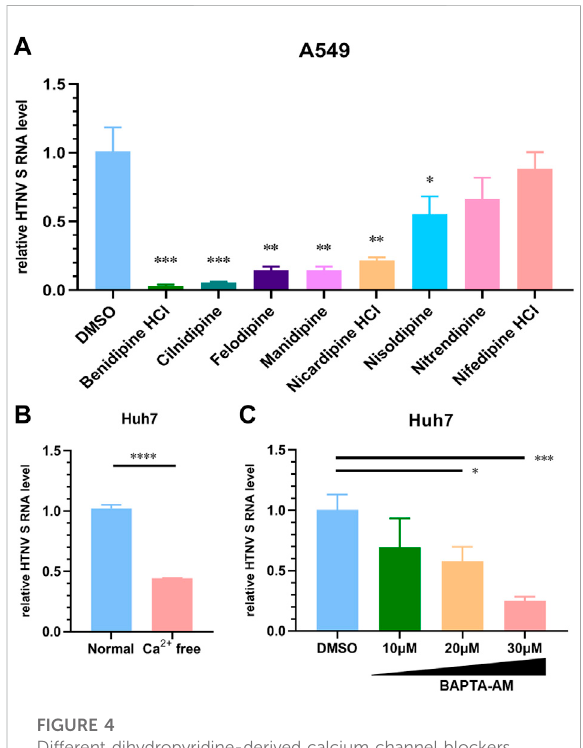
FIGURE 4 Different dihydropyridine-derived calcium channel blockers inhibit HTNV infection. (A) A549 cells were treated with the indicated CCBs or the DMSO vehicle and infected with HTNV at MOI 1, and the relative level of S segment RNA was determined by normalizing to GAPDH. (B) Huh7 cells were cultured in Ca 2+ -free or normal medium and then infected with HTNV (MOI = 1), 24 hpi; the relative intracellular HTNV RNA level was measured by qRT-PCR. (C) Huh7 cells were infected with HTNV upon treatment with BAPTA-AM, 24 hpi. The relative intracellular HTNV RNA level was measured by qRT-PCR. * p < 0.05; ** p < 0.01; *** p <